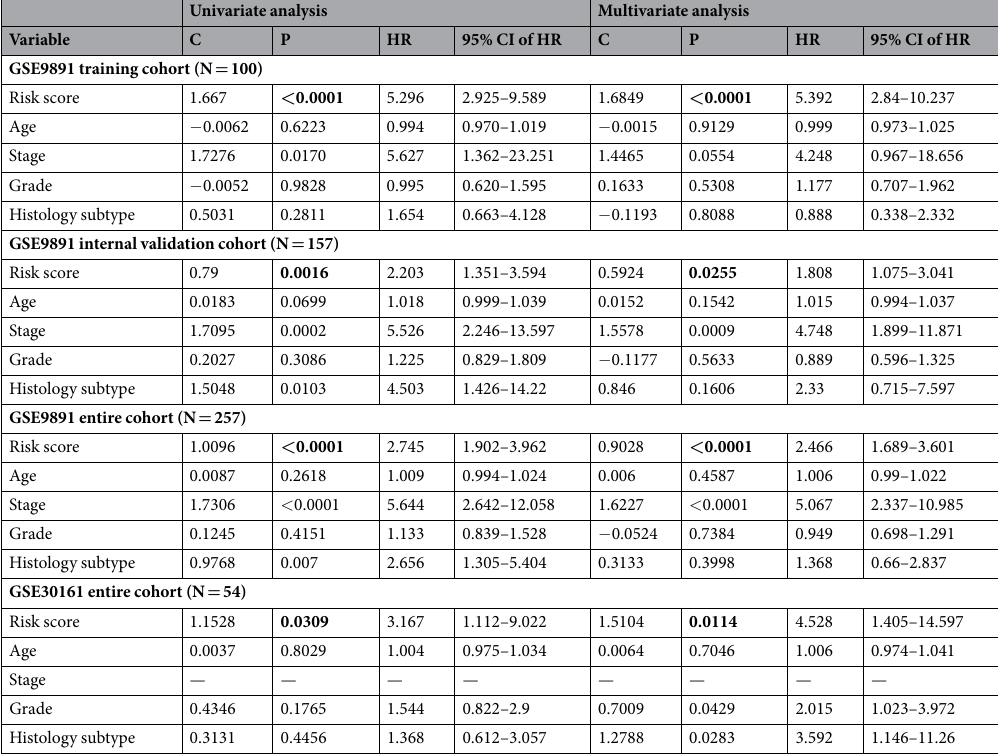
Table 2. Univariate and multivariate cox regression analyses of DFS in GSE9891 and GSE30161. Abbreviations: C Coefficient, P P value, HR Hazard Ratio, CI Confidence Interval.